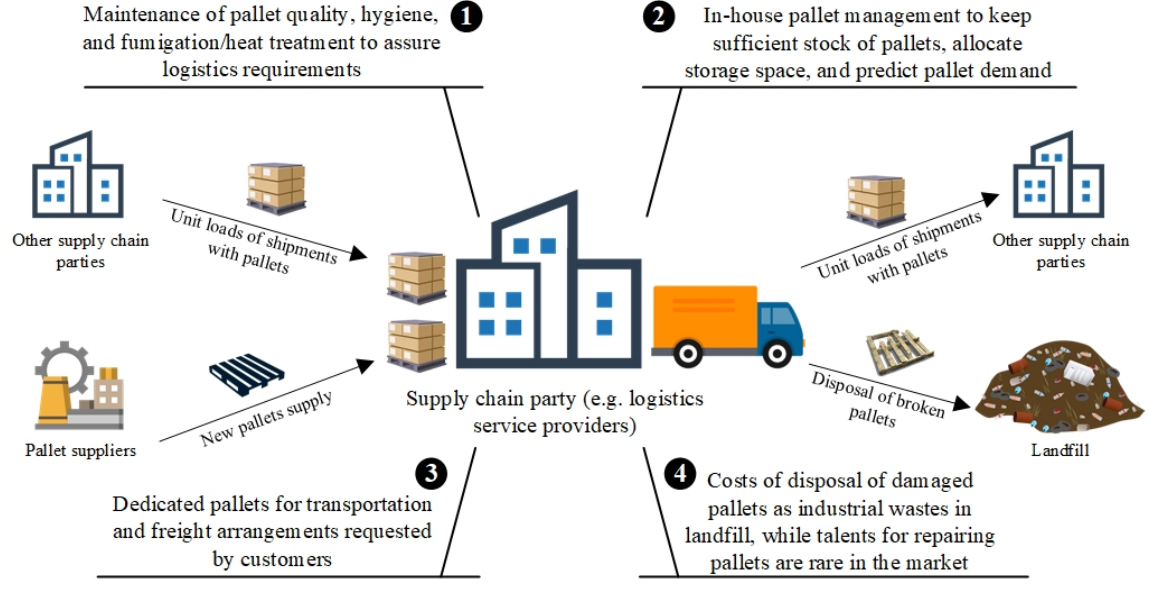
Figure 1. Pitfalls of traditional pallet management in the logistics and supply chain management.